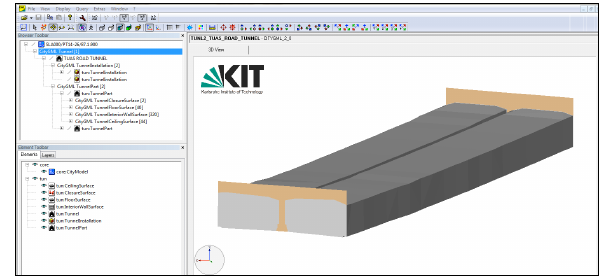
Figure 10. A LOD 2 Tunnel model